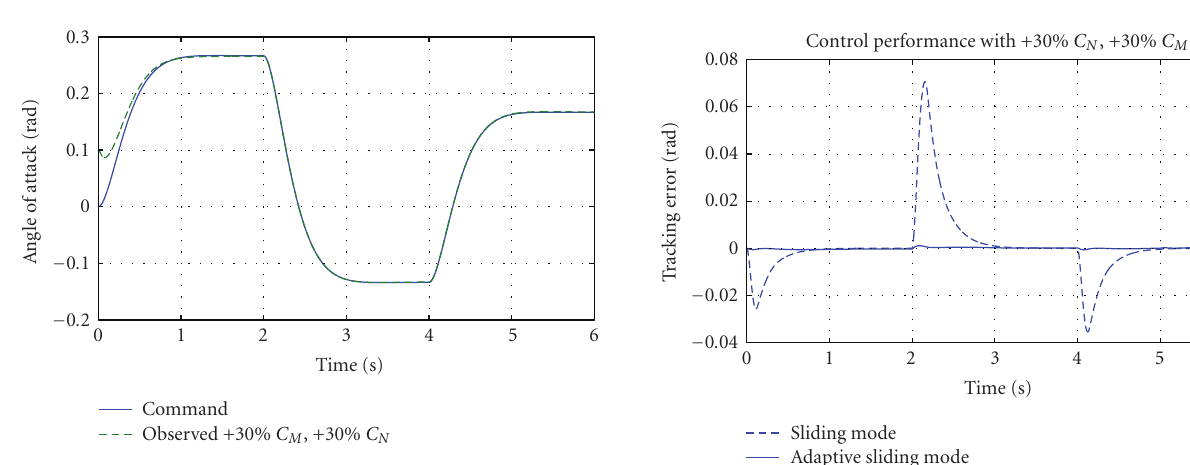
Figure 17: Output tracking with adaptive sliding observer-control.